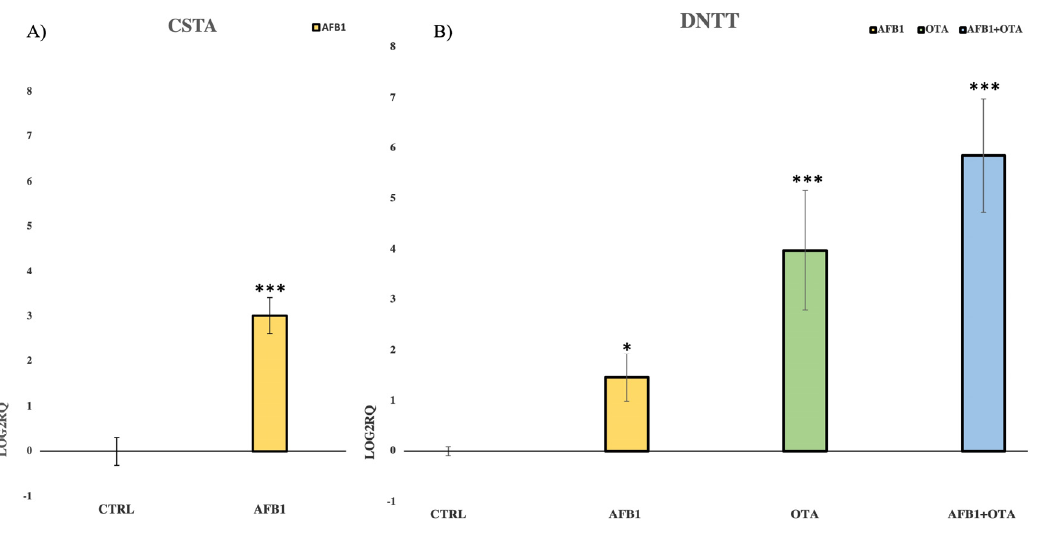
Figure 5. Bar plots showing the relative expression of ( A ) CSTA and ( B ) DNTT when compared to the control (Log2RQ = 0) after 7 days of exposure in Jurkat cells to AFB1 (100 nM) for CSTA and to AFB1, OTA, AFB1 + OTA (100 nM in all cases) for DNTT by qPCR. RQ: relative quantification; CTRL: control; CSTA: cystatin A; DNTT: DNA nucleotidylexotransferase. p ≤ 0.05 (*), p ≤ 0.001 (***).